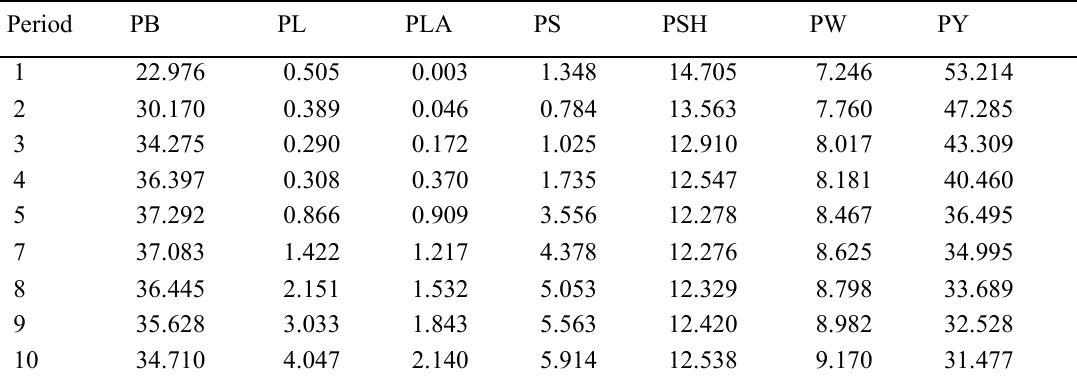
Table 5. Analysis of variance for cotton